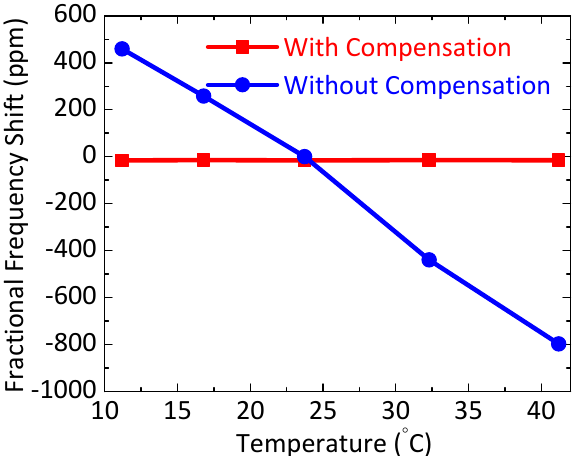
Figure 10. Fractional frequency shift (in ppm) as the device temperature is varied, measured from both